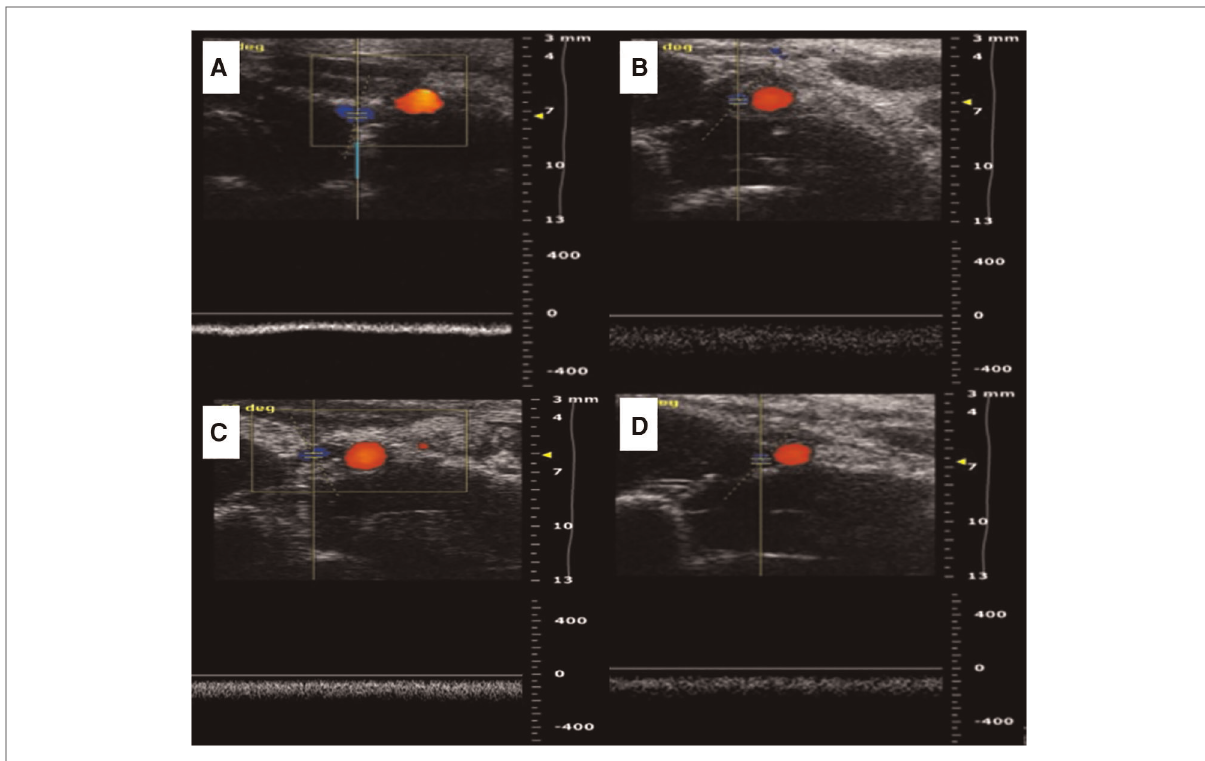
FIGURE 3 Two kinds of vascular ultrasound in vein replacement model. ( A ) Abdominal ultrasound at 1 week after operation in the cuff group. ( B ) Abdominal ultrasound at 4 weeks after operation in the cuff group. ( C ) Abdominal ultrasound at 1 week after operation in the suture group. ( D ) Abdominal ultrasound at 4 weeks after operation in the suture